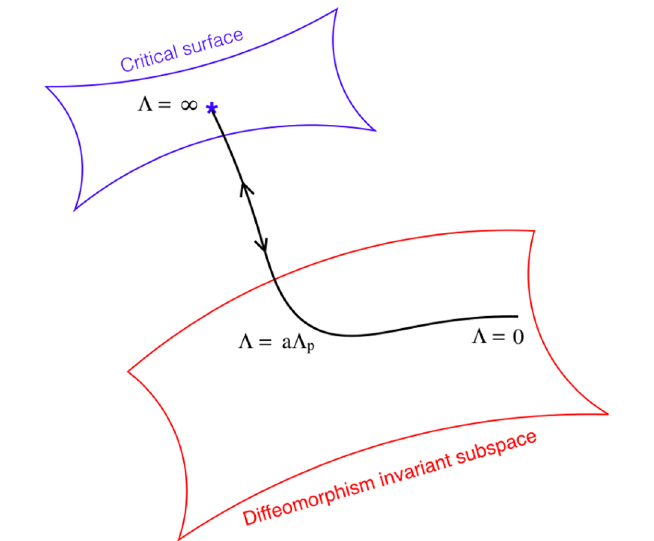
Figure 1 . The continuum limit is described by a renormalized trajectory that shoots out of the Gaussian (cid:12)xed point (free gravitons) along relevant directions that cannot respect di(cid:11)eomorphism invariance for (cid:3) > a (cid:3) p , where (cid:3) p is a characteristic of the renormalized trajectory and is